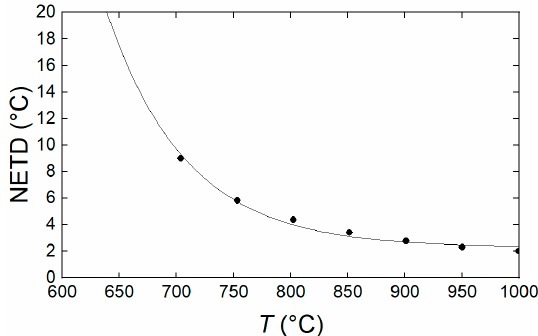
Table 2. Components of combined uncertainty.